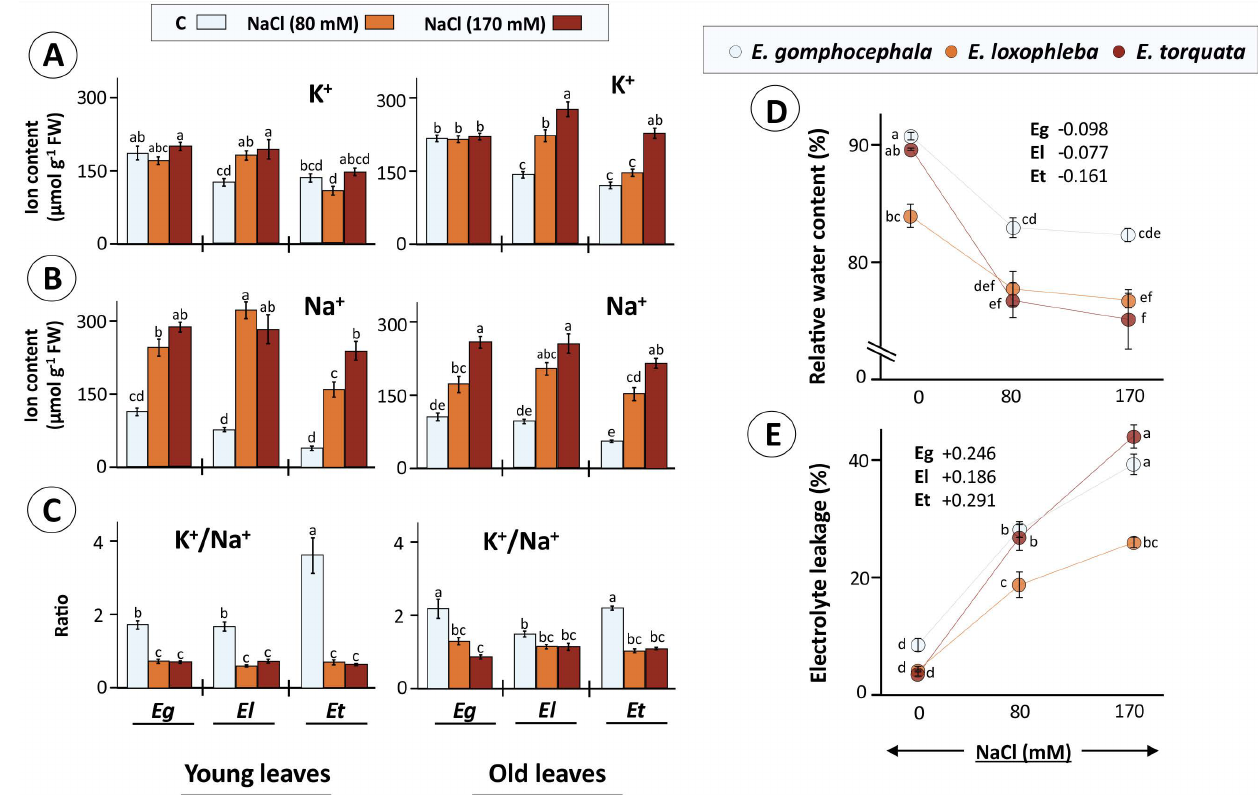
Figure 3. Osmotic and ionic burden as faced by Eucalyptus grown in saline conditions. Eucalyptus spp exposed to salinity (80 and 170 mM NaCl) experienced both osmotic stress as well as ionic imbalance which was measured as tissue K + ( A ) and Na + ( B ) contents in young and old Eucalyptus leaves and their ratios ( C ) as well as relative water content (RWC) ( D ) and membrane integrity (electrolyte leakage; EL) ( E ). RWC and EL scatter plots also provide values for slopes for each species indicating NaCl effects (only 80 mM as effect saturates for 170 mM). Data are mean ± SE, n = 4 (RWC, EL) and 5 (ion contents). Ca 2+ contents are given in Supplementary Materials Figure S3A,B. Significant differences are based on ANOVA with Tukey’s post-hoc test ( p <